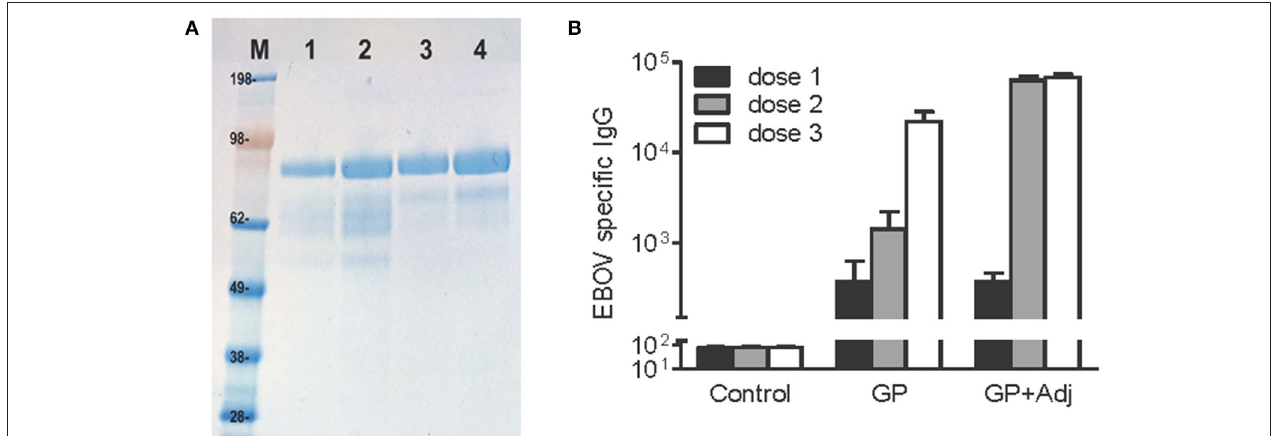
FIGURE 1 | Highly purified, recombinant EBOV GP induces potent antibody responses after two and three doses. (A) EBOV GP protein on SDS-PAGE stained using Coomassie blue. M, molecular weight marker, Lanes 1–2, 1 and 2 µ g of single-step immunoaffinity purified GP protein (90% purity) and lanes 3–4, 1 and 2 µ g of protein after 2-step purification (95% purity). (B) BALB/c mice were inoculated with GP (10 µ g per dose) via subcutaneous route with or without adjuvant, followed by two booster doses in 4-week intervals. EBOV specific IgG was measured using a standard ELISA reporting endpoint titers (absorption > 0.2 above background). Y-axis: GMT +